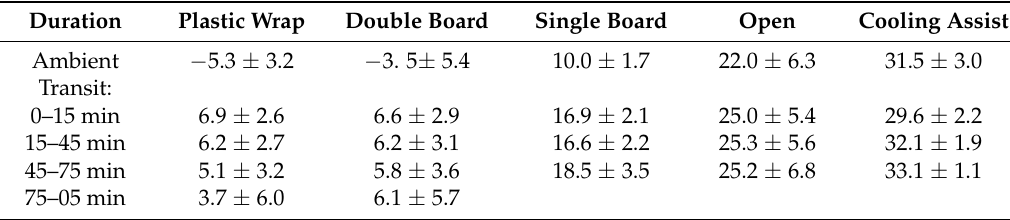
Table 3. Mean recorded temperature ( ◦ C) of 15 or 30-min segments during transit under five trailer configurations found in commercial broiler transporters.